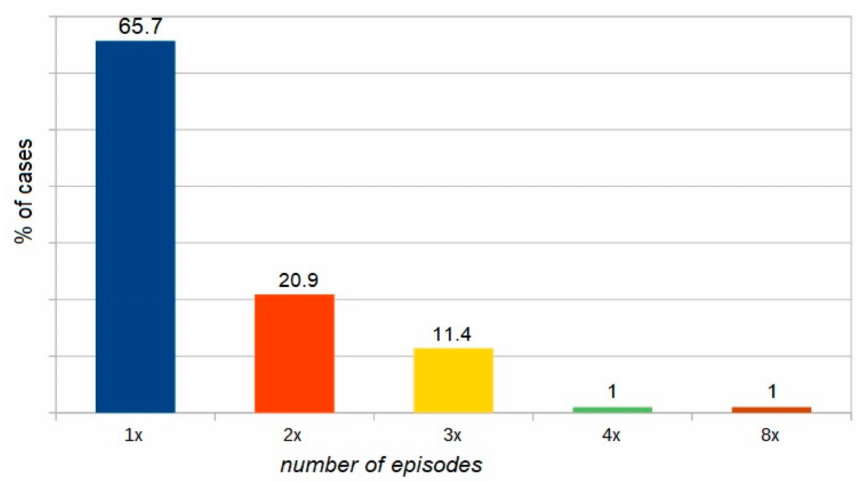
Figure 7. The proportion of patients with drug-induced anaphylaxis versus the number of episodes (one vs. two vs. three vs. four vs. eight).